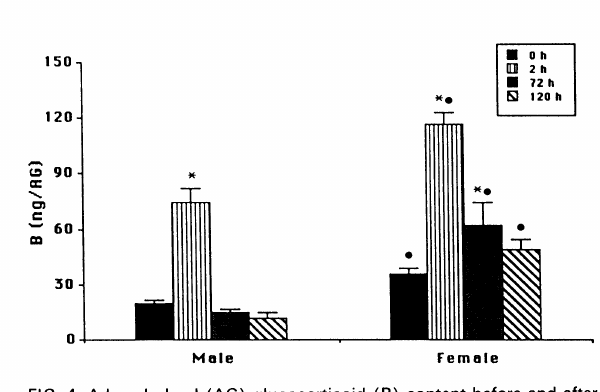
___ FIG. 4. Adrenal gland (AG) glucocorticoid (B) content before and after S.E.M. LPS treatment in male and female mice. Bars represent the mean ,, (n 6-8 mice per group). p < 0.05 or less vs. the respective sample time zero. o, p < 0.05 vs. male values at the same time interval.